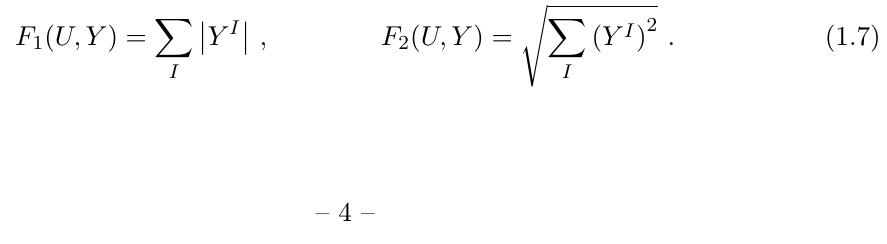
Figure 1 . A general quantum circuit where j sequence of elementary unitaries g i . We also indicate all of the intermediate states j i i that are produced after every